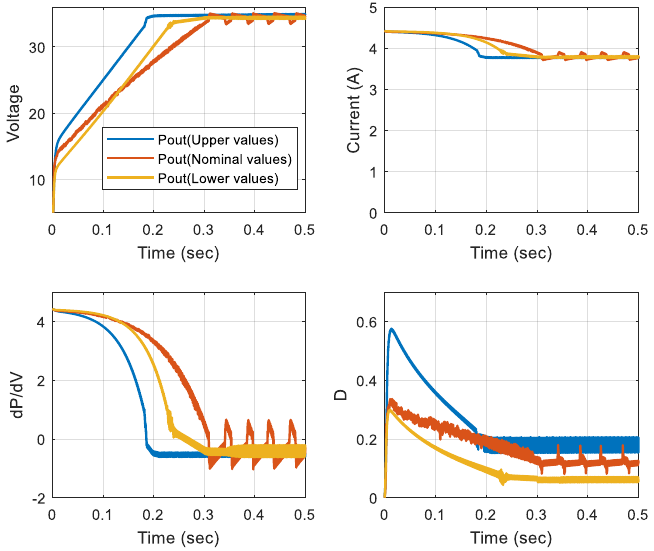
Figure 14. Voltage, current, dP / dV, and D for di ff erent MPPT parameters.